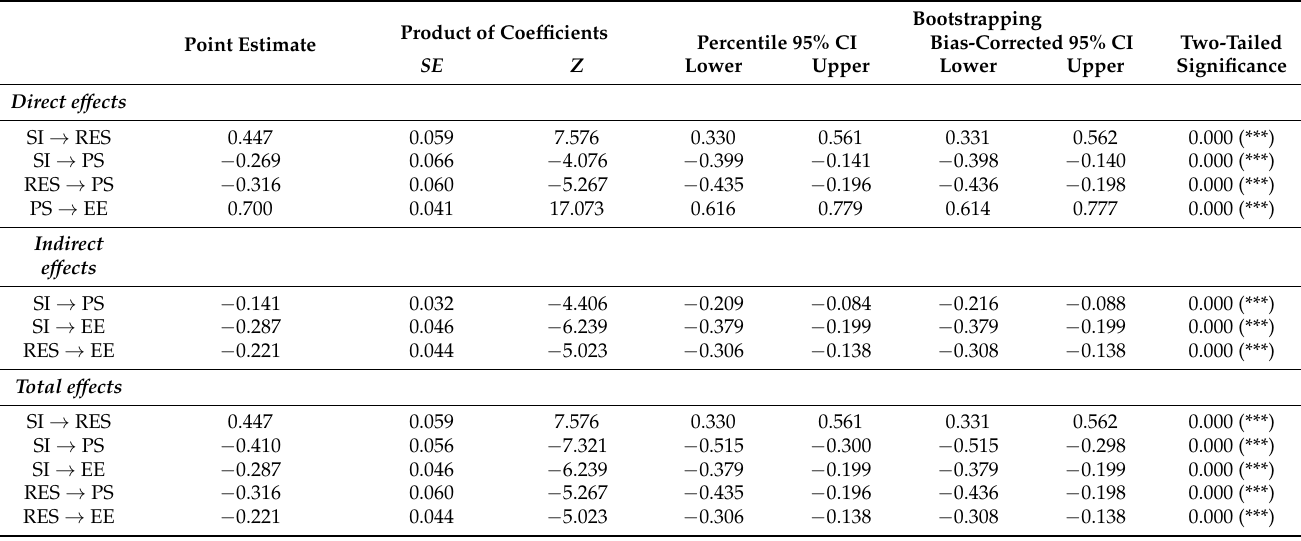
Table 4. Standardized direct, indirect, and total